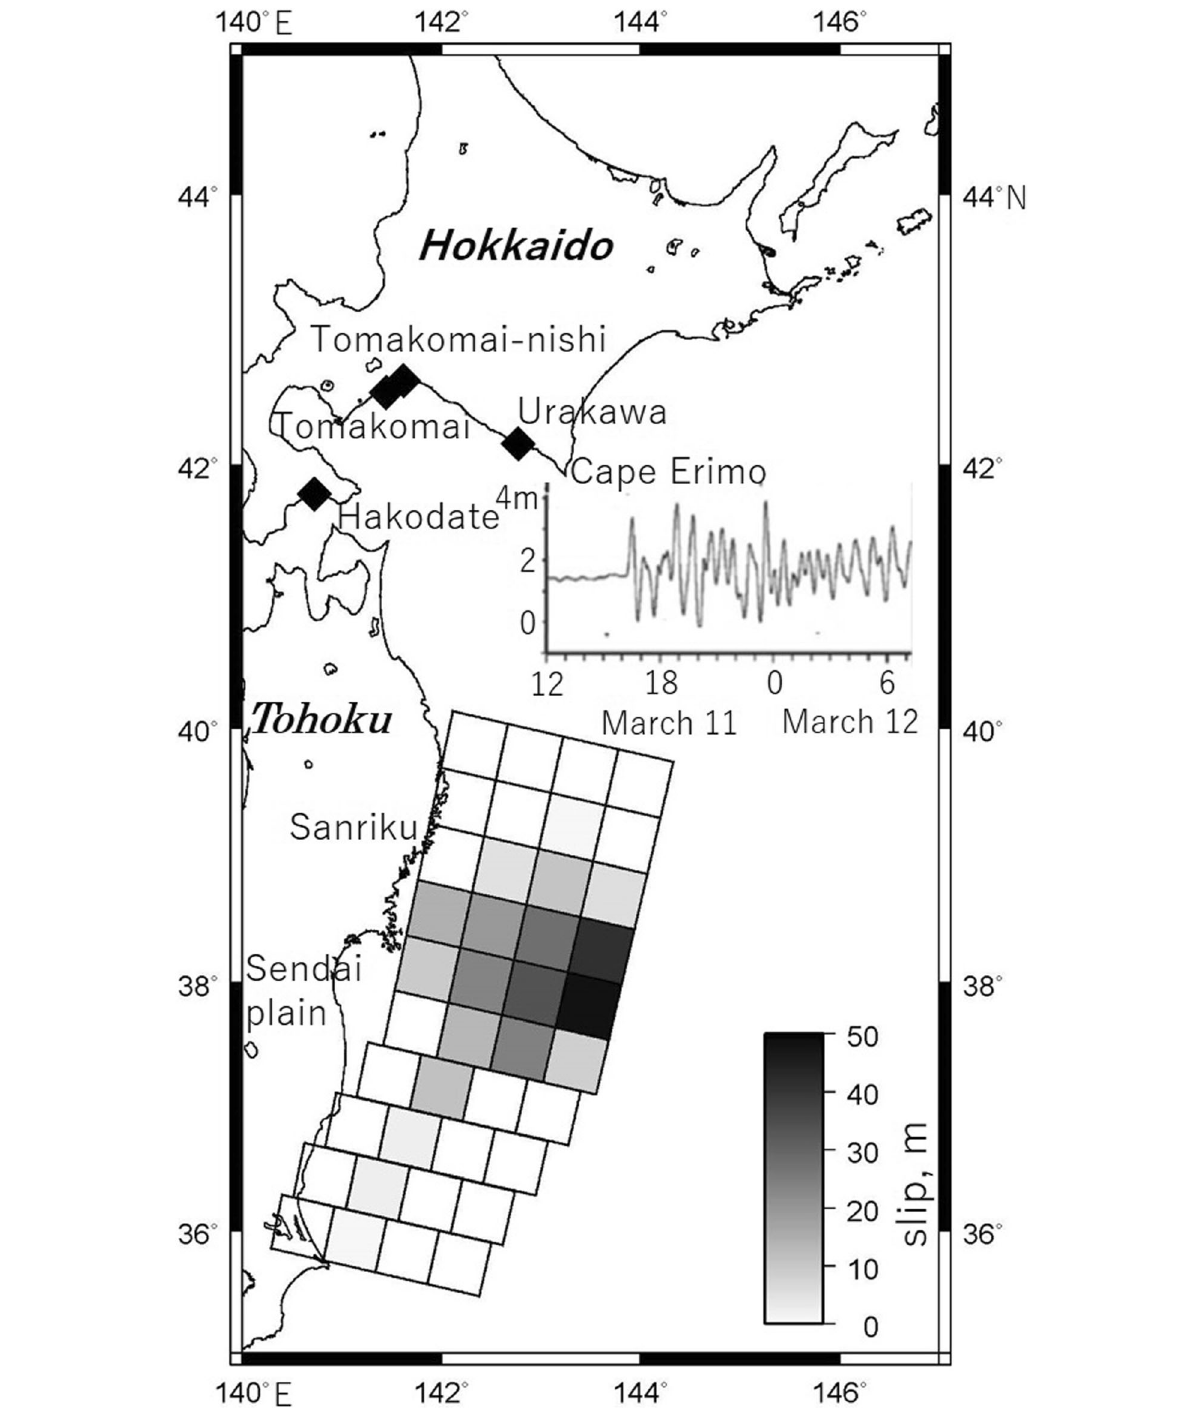
Fig. 1 The slip distribution of the 2011 Tohoku-oki earthquake (Fujii et al. 2011) used to compute tsunamis in this study. The diamonds show the locations of the four tide gauges, that is, Hakodate, Tomakomai, Tomakomai-nishi, and Urakawa, to compare the observed and computed tsunami waveforms. The original tsunami waveform (without tide removal) observed in Hakodate (Japan Meteorological Agency 2012) is displayed in the